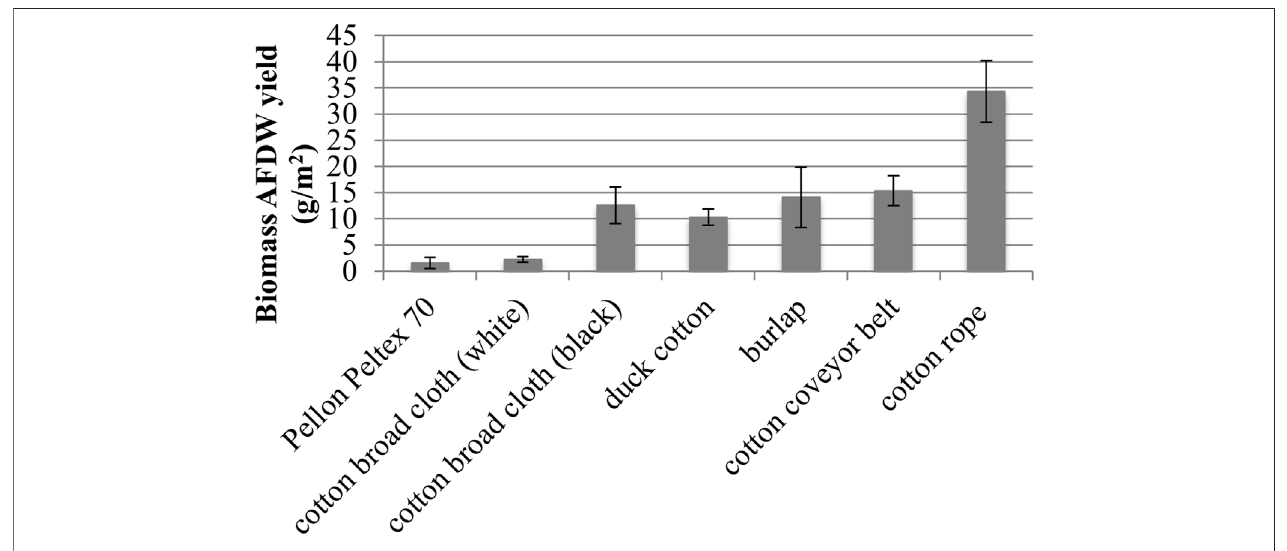
FIGURE 5 | Growth Substratum Evaluation of biomass Ash Free Dry Weight (AFDW) yields ( ■ ) (one standard deviation shown, n = 2).